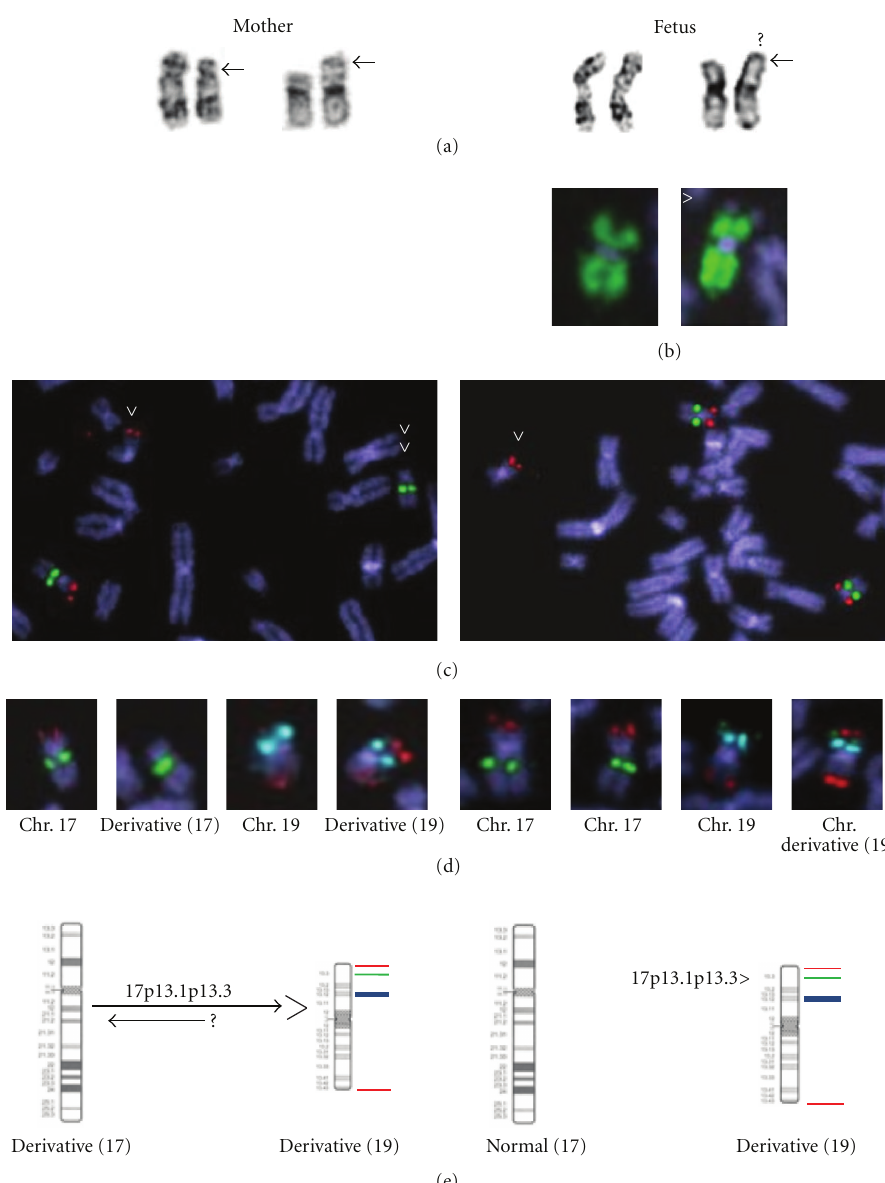
Figure 1: Chromosome and FISH results. On the right side fetus (amciocytes) and left side mother (lymphocytes). All FISH probes were from Vysis-Abbott. (a) Karyogram images of chromosomes 17 and 19. Both the fetus and the mother have additional material in chromosome 19p. The fetus has normal chromosomes 17 but the mother has a deletion in one chromosome 17p indicating that she is a carrier of a potentially balanced translocation. (b) Chromosome painting with a wcp19 probe shows a small unpainted terminal region on chromosome 19p (arrowhead). (c) MDS microdeletion specific probe (17p13.3-red/LIS1-gene and 17q21-green/RARA-gene) for the fetus and the mother. An extra red signal is seen on the der(19) chromosome both in the fetus and in the mother (1x arrowhead). In the mother the Miller Dieker syndrome specific probe shows MDS probe on der(19) and the control probe on der(17). 2x arrowheads point to the der(17) of the mother that lacks the MDS probe signal. (d) Simultaneous hybridization with MDS probe and subtelomere probe set for chromosome 19 (19p/19p13/19q, ToTelVysion, Vysis-Abbott) shows the order of these probes indicating that the MDS region has been translocated/inserted distal to the 19p subtelomere region in the der(19). (Mixtures 8 and 14 were applied from ToTelVysion probe kit, which are specific for chromosome 17p subtel/17cep and 19p subtel/19p13/19q, respectively). (e) Ideogram images of chromosomes 17 and 19. FISH probes are marked from p arm to q arm with di ff erent colour